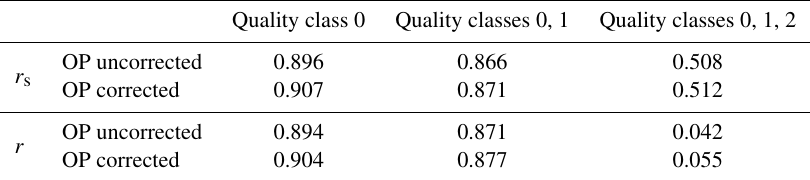
Figure 3. Effect of the self-heating correction on the correlation between open-path (OP) and closed-path (CP) fluxes (a) . Correlations were quantified using Spearman’s rank correlation coefficient r s and Pearson’s correlation coefficient r . Only quality class 0 is shown. Negative fluxes are affected more strongly by the correction than positive fluxes (b) . Table 5. Spearman’s rank correlation coefficient r s and Pearson’s correlation coefficient r between closed-path (CP) and open-path (OP) fluxes with and without the applied self-heating correction. The agreement between CP and OP fluxes increases throughout all quality classes after OP